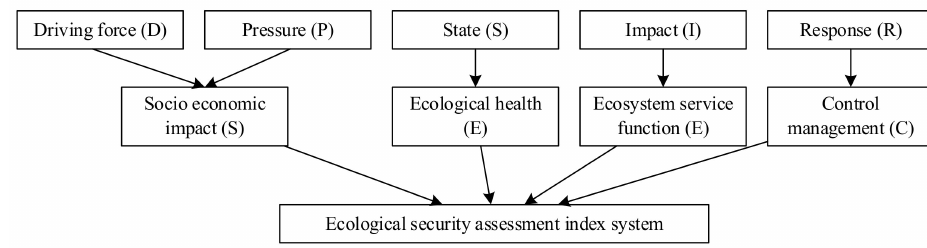
Figure 1. Framework of the SEEC